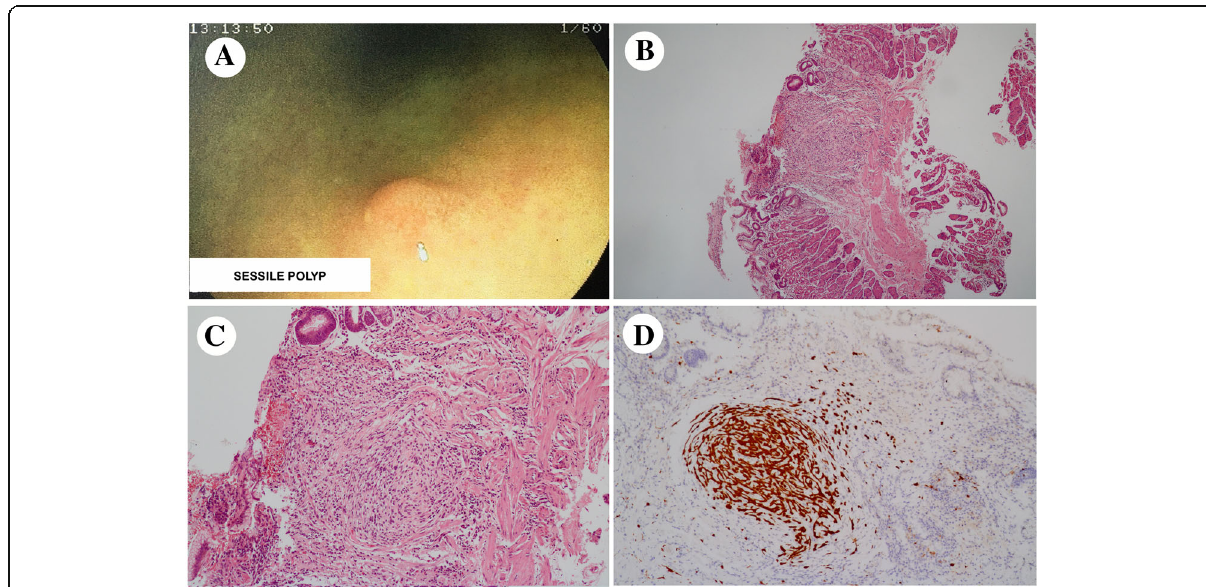
poorly circumscribed spindle cell lesion with no significant atypia: b 40x magnification; c 100x magnification. Mucosal Schwann cell hamartoma in the gastric mucosa. Strong and diffuse immunohistochemical staining for S100 protein (100x magnification) ( d )